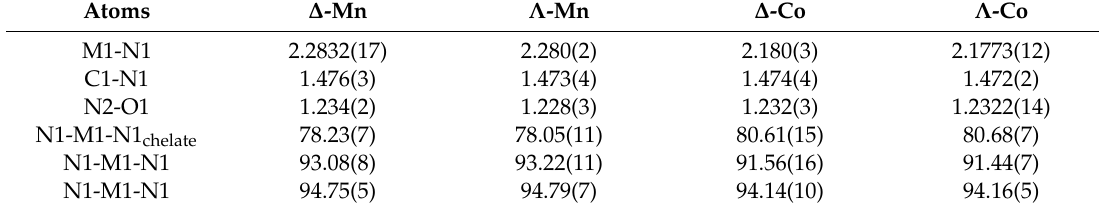
Table 2. Selected bond distances (Å) and angles ( ◦ ) for [Mn(en) 3 ](NO 3 ) 2 and [Co(en) 3 ](NO 3 ) 2 at 298 K.